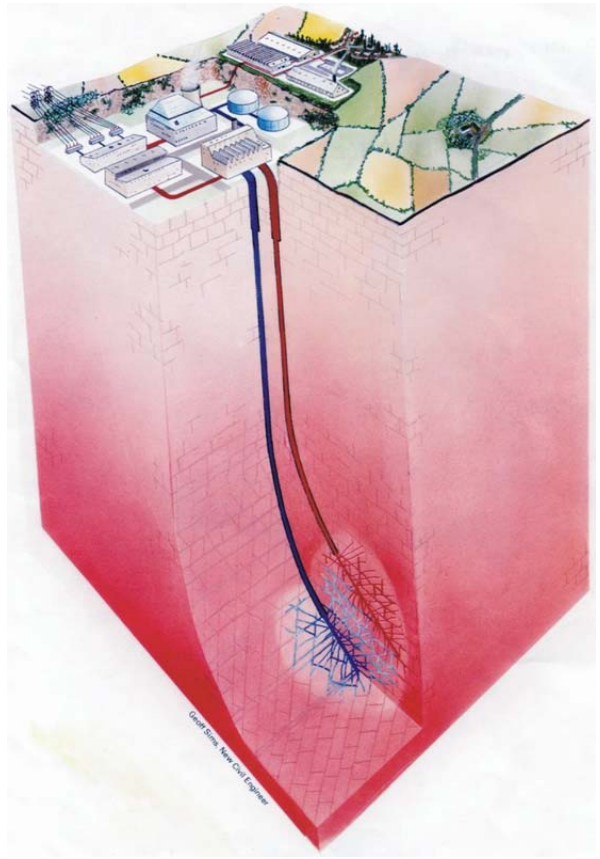
Figure 70. Schematic of the Hot Dry Rock technology. © 2004 IGA, reproduced from [310] with